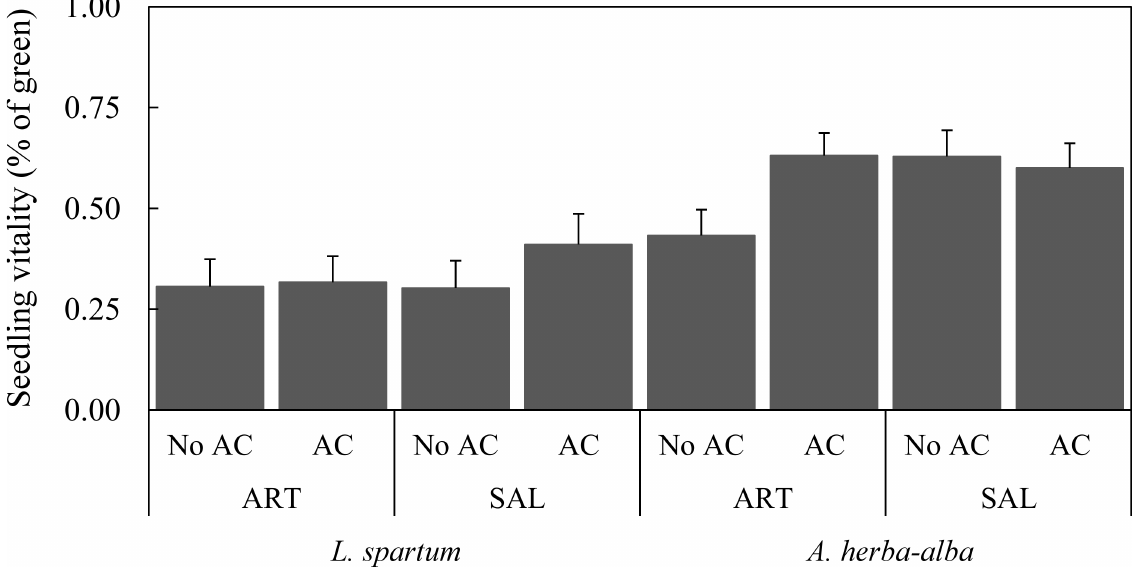
Fig 2. Vitality (mean % of green parts ± SE) of target species juveniles by treatment and shrub microsite. ART, A . herba-alba ; SAL, S . vermiculata